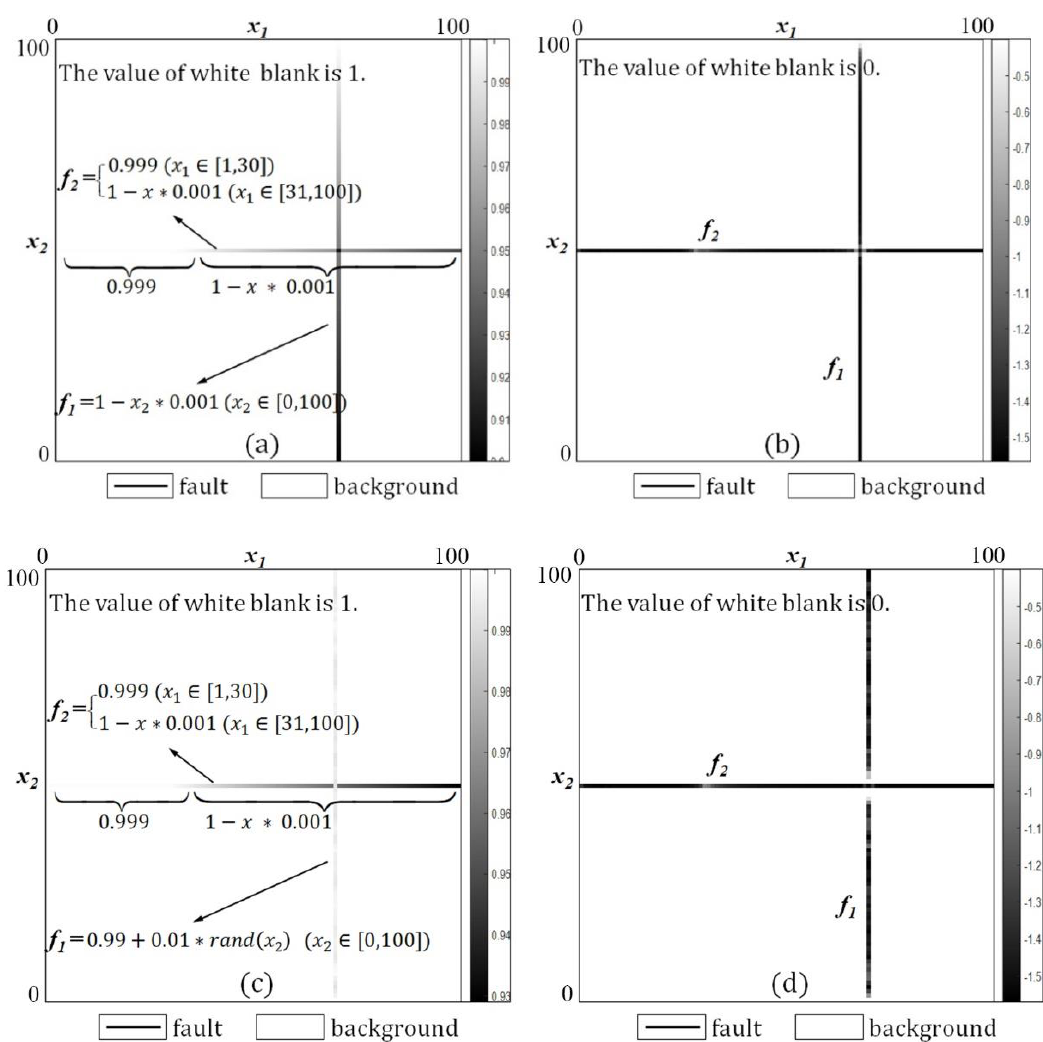
Figure 1. Coherence and PC slices of model data. ( a ): The coherence of model 1. ( b ): The PC result of ( a ). ( c ): The coherence of model 2. ( d ): The PC result of ( c ). The white blank denotes horizontal background and the dark lines indicate faults.